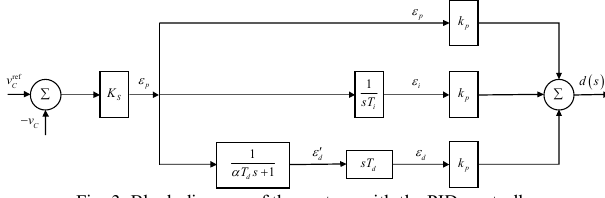
Fig. 3. Block diagram of the system with the PID